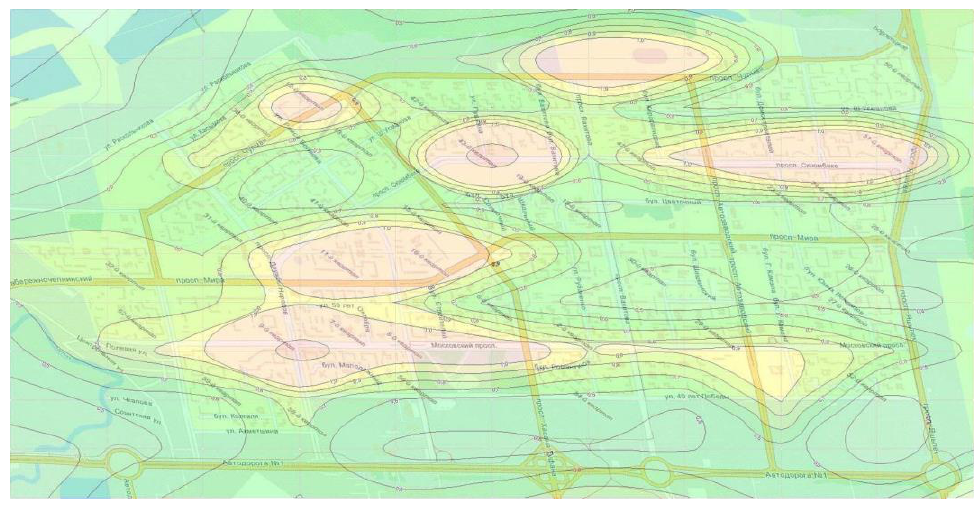
Figure 2. Map of CO dispersion in Naberezhnye Chelny.